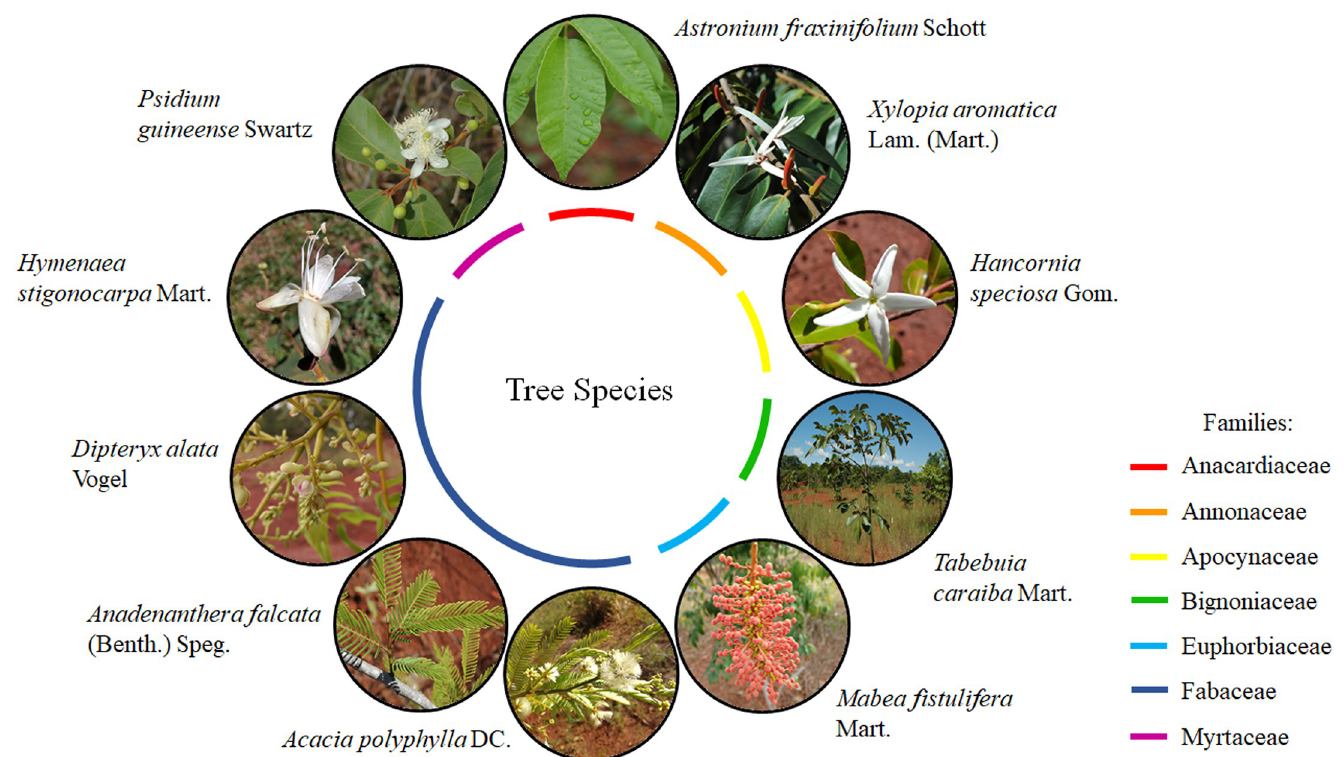
Fig 3. Native tree species introduced as seedlings to the restoration management (RM)